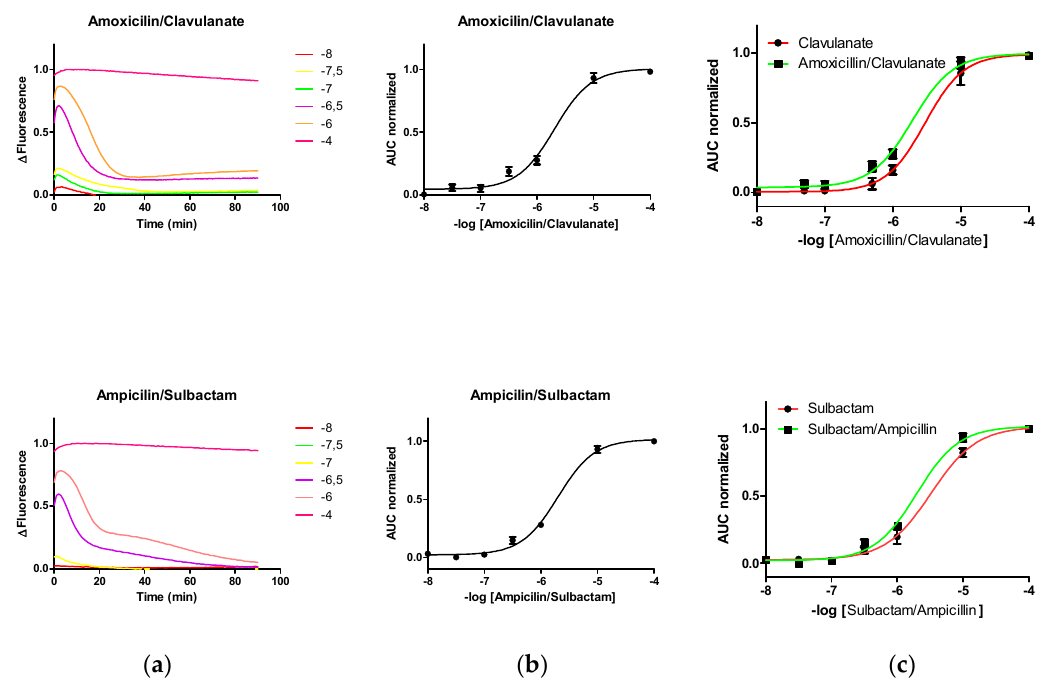
Figure 3. Time-course fluorescence of PenP with different concentrations of amoxicillin/clavulanic acid ( a ) and ampicillin/sulbactam ( b ) Boltzmann curves, for each composition, of area under the curve normalized of fluorescence against –log concentration of antibiotic; ( c ) Effects of LI on PenP curves at the same LA concentrations.